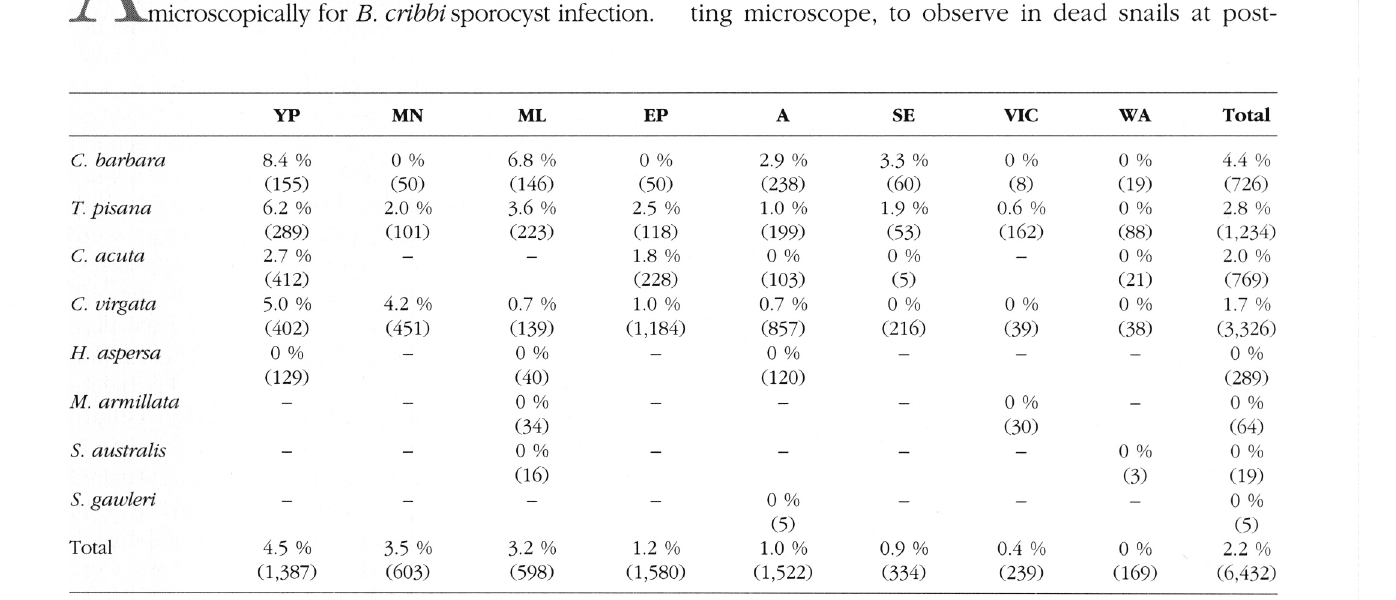
Table I. - Percentages of infection with B. cribbi sporocysts in land snails across eight geographical districts of southern Australia. Col­ lection sites were grouped into six districts in South Australia: Yorke Peninsula (YP), Mid-North (MN), Murray Lands (ML), Eyre Peninsula (EP), Adelaide/Adelaide Hills/Barossa Valley/Fleurieu Peninsular (A) and the South East (SE). Other collection sites were in the states of Western Australia (WA) and Victoria (VIC). ( ) = number of snails